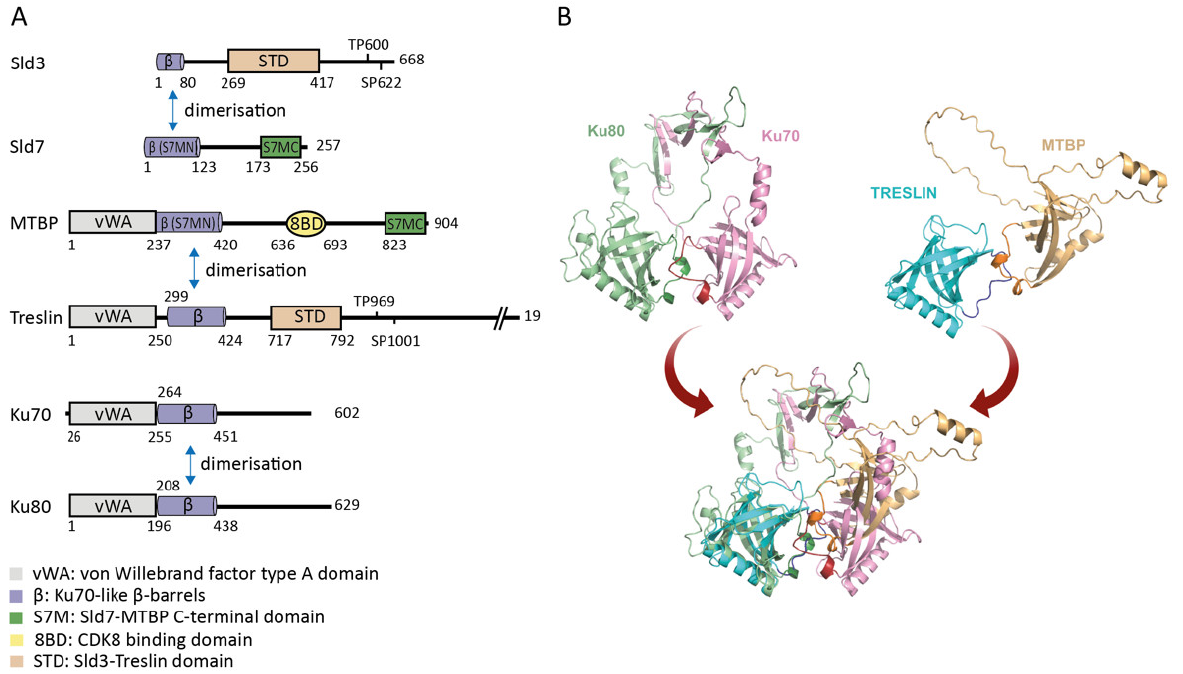
Figure 2. Structure of MTBP–Sld7 and related proteins (A) Domain architecture of Sld3/Treslin, Sld7/MTBP sharing a dimerizing Ku70-like β-barrel (β) and vWA (von Willebrand factor type A domain, Treslin/TICRR and MTBP only) domains. Protein length and amino acid position are indicated by corresponding numbers. CDK sites for Treslin/TICRR (positions 969 and 1001) and Sld3 (positions 600 and 622) are indicated. ( B ) Similar modes of interaction in Ku70-Ku80 (pbd 1JEY) and MTBP-Treslin/TICRR heterodimers are suggested by structural prediction of the MTBP-Treslin/TICRR dimer. The prediction was made using Alphafold2-advanced (Google Colab). The top models show the individual heterodimers that were superimposed to generate the bottom panel. Darker colors indicate equivalent loops between two beta-strands (b3-b4) of MTBP, Treslin, Ku70 and Ku80 that form intimate contacts. The predicted structure suggests that a different relative orientation of the β -barrels in MTBP-Treslin/TICRR may exist, but this prediction needs further experimental clarification.